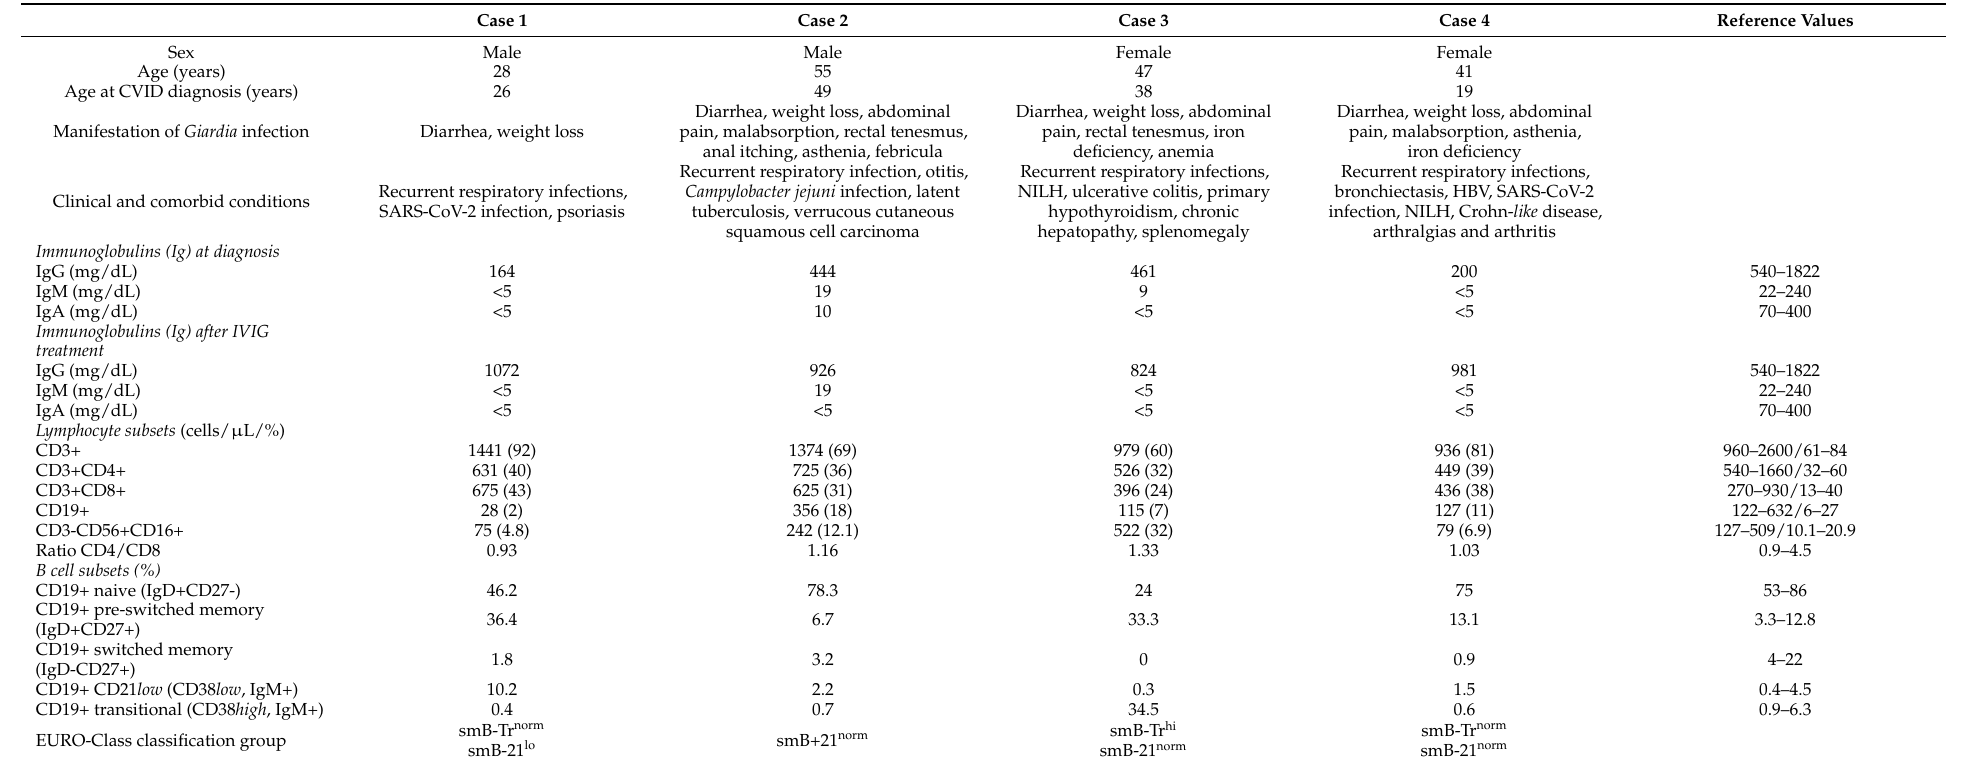
Table 1. Epidemiological, clinical and immunological characteristics of patients with Giardia infection and